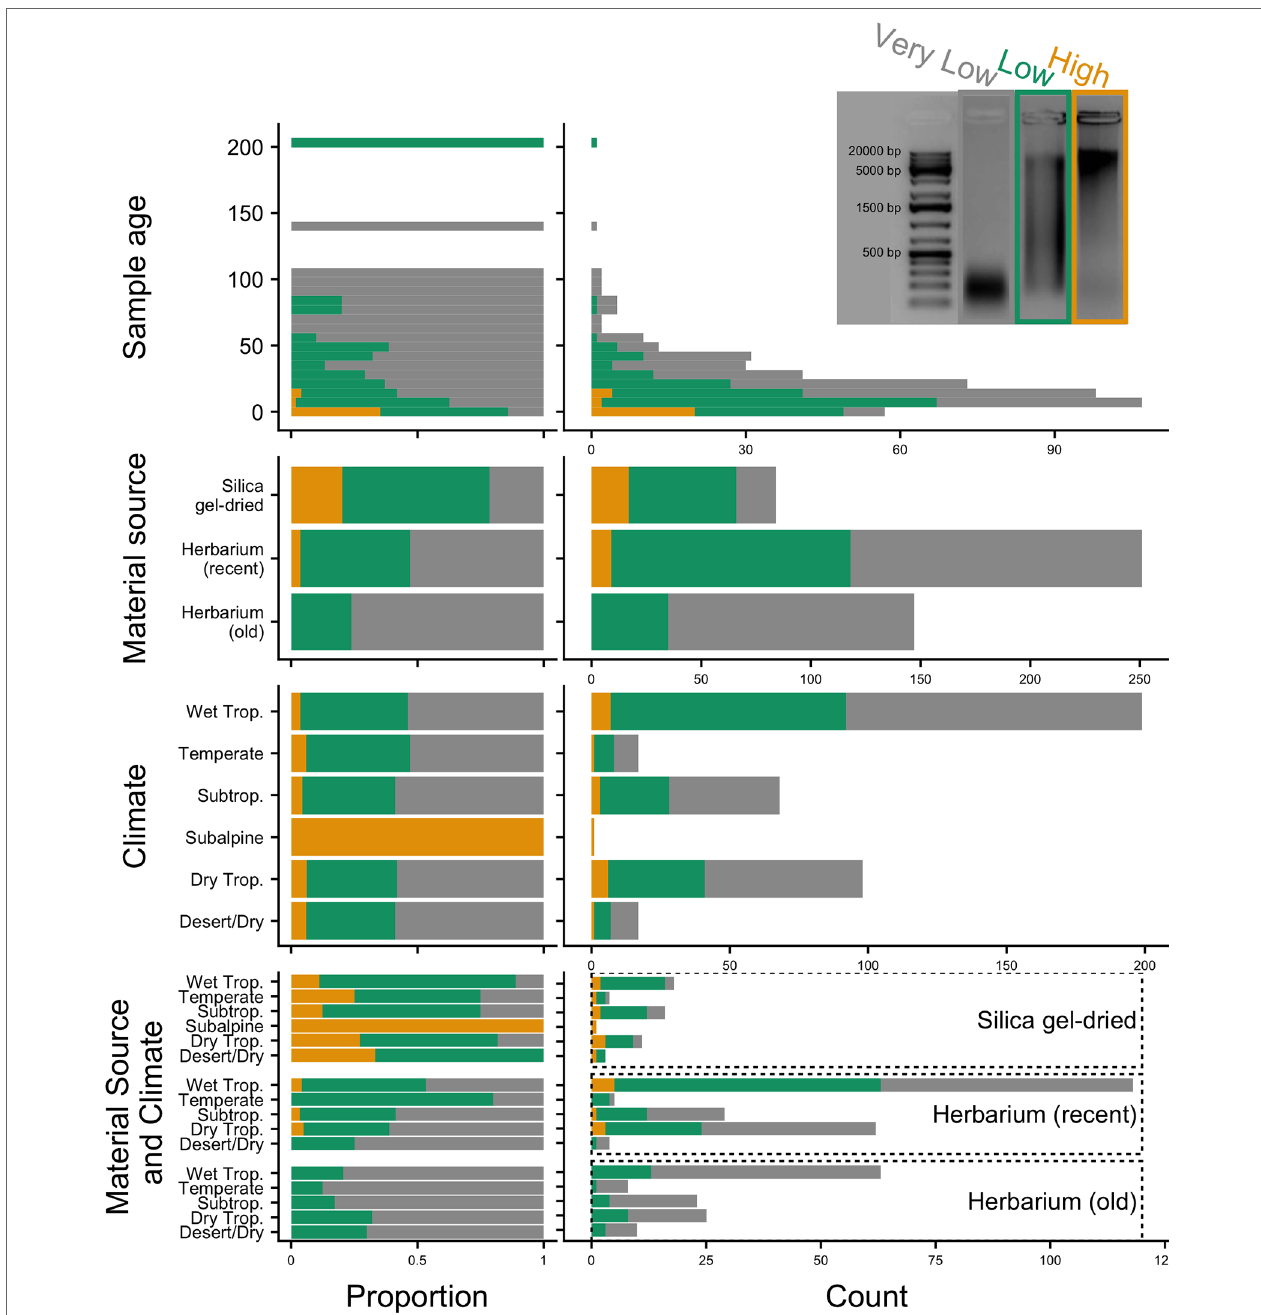
FIGURE 2 | Genomic DNA quality according to sample age, material source, climate (according to species distributions), and material source and climate combined, in relative (proportion) and absolute (count) values. Quality is defined as very low (severely fragmented DNA <500 bp), low (DNA smear on agarose gel), or high (high-molecular-weight DNA >5